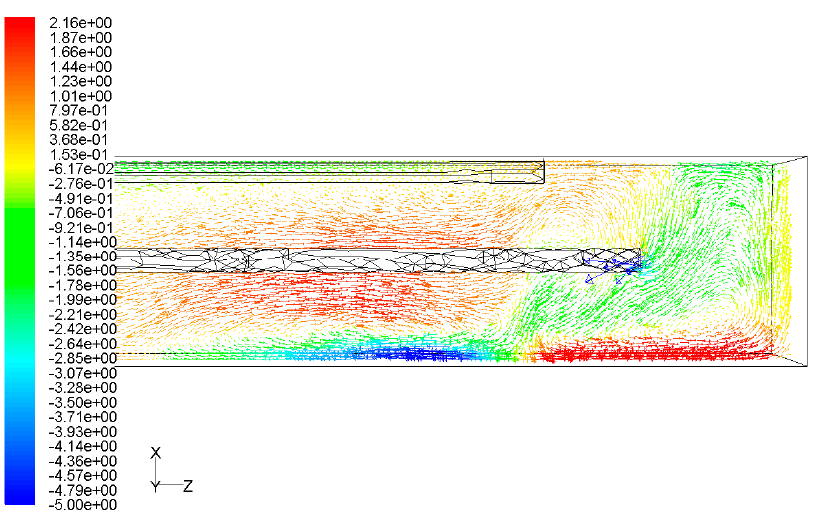
Figure 9. Airflow velocity vector 5 m away from the heading face (m/s).